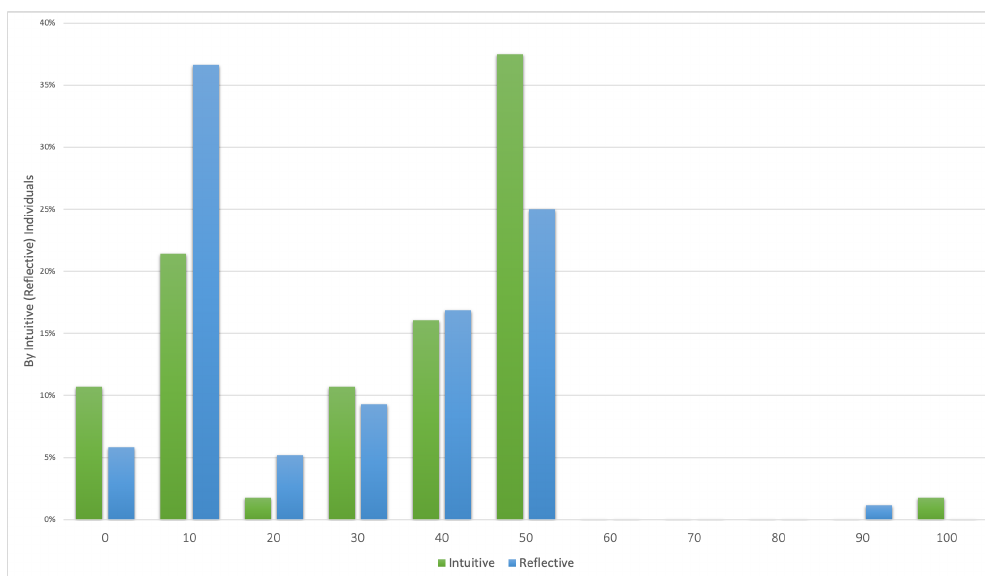
Figure A4. Frequency of Ultimatum Game Acceptance Threshold by Intuitive (Reflective) Individuals.